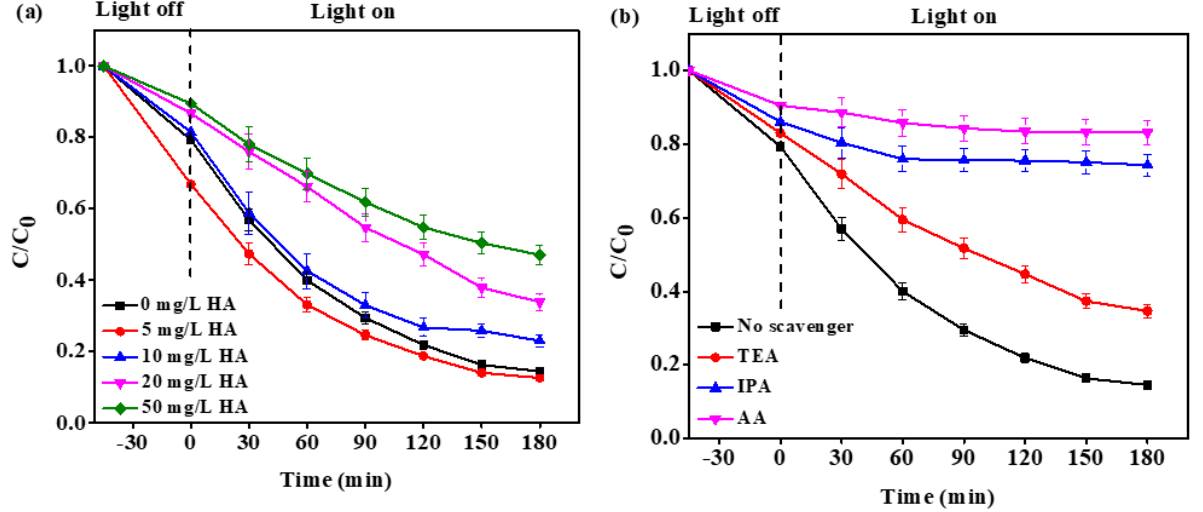
Figure 8. ( a ) Effect of HA on the TC removal; ( b ) the effect of radical scavengers on the photodegradation of TC using 8%-ZT@LLDPE film ([TC] = 40 mg/L; pH 9; lamp power: 48 W).